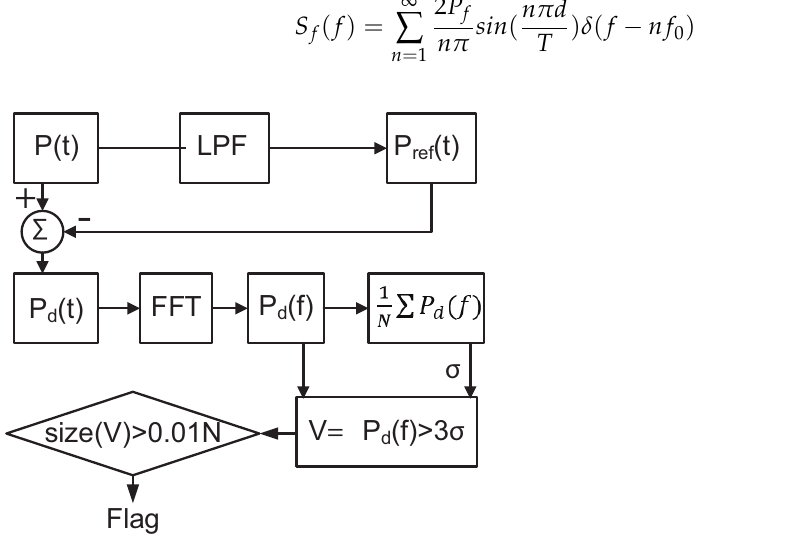
Figure 7. Detection